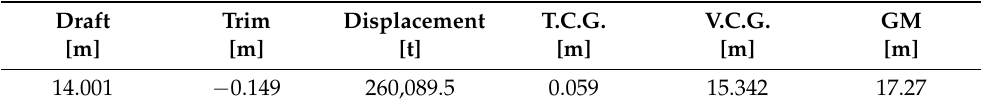
Table 4. Parameters of “PACIFIC VISION” under load condition LOADA02, from [61].